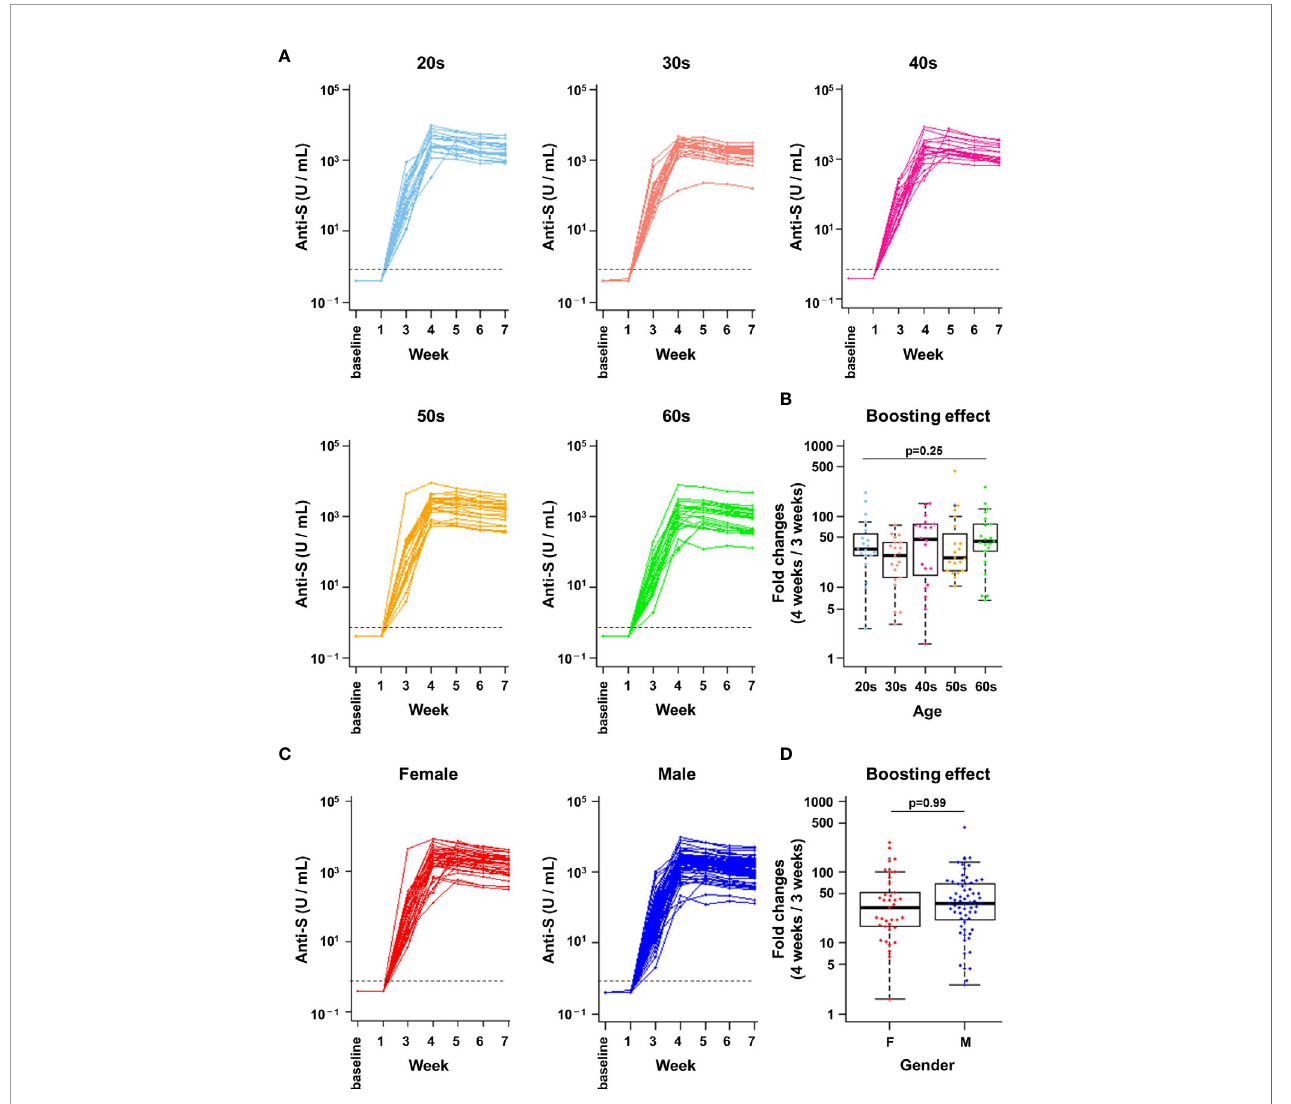
FIGURE 2 | A robust boosting effect after the second vaccine dose was observed in individuals of all ages and genders. (A, C) Anti-spike (S) protein antibody titres in infection-naïve healthcare workers (n=103). The kinetics of antibody titres (U/mL) are indicated from baseline to 7 weeks after the fi rst dose. Data by age group (A) and by gender (C) are shown. The dotted line indicates the cut-off value (0.8 U/mL). (B, D) Boosting effect before and after the second vaccine dose. The ratios of antibody titres immediately before (3 weeks) and 1 week after the second dose (4 weeks) are indicated. Data by age group (B) and by gender (D) are shown. There were no statistically signi fi cant differences in boosting effect between age groups (p = 0.25, Kruskal-Wallis test) or genders (p = 0.99, Student ’ s t-test). F, female; M,